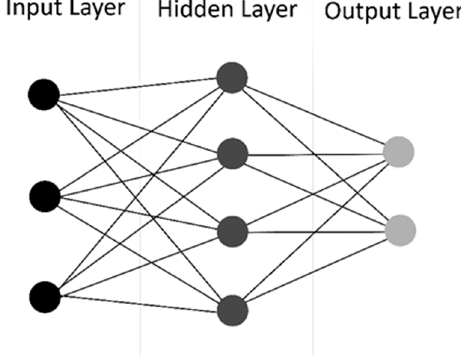
Figure 7. Simplified structure of artificial neural networks.